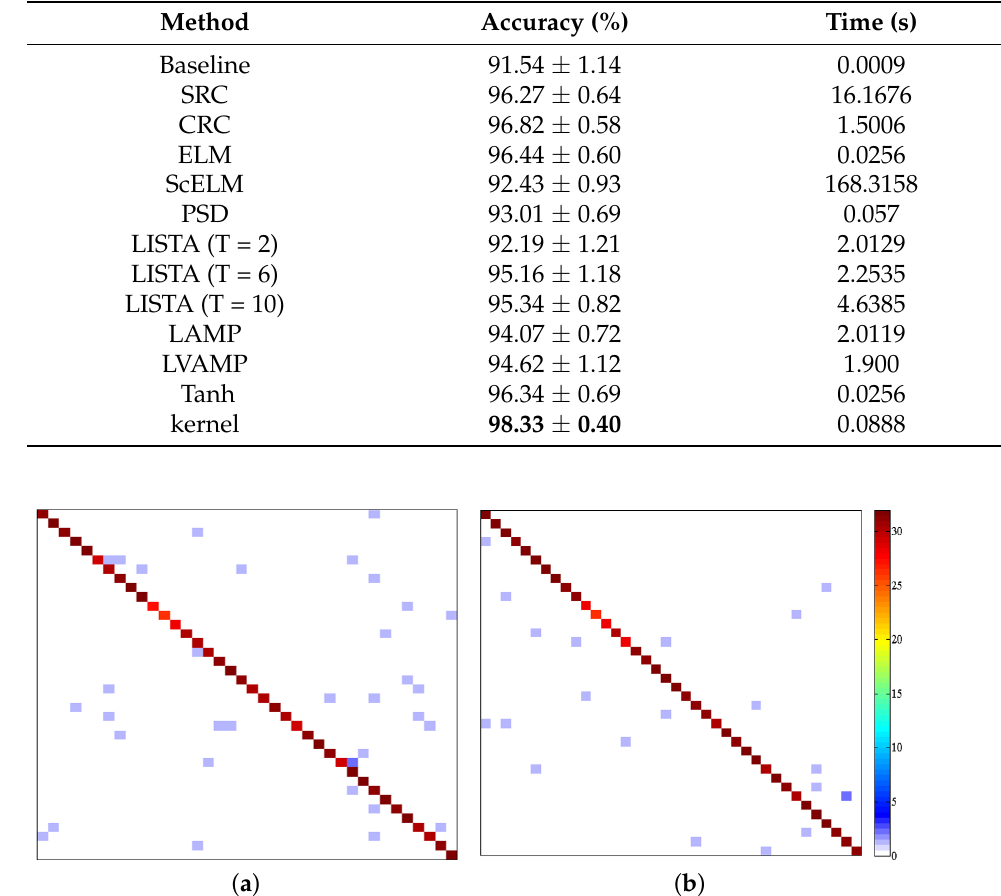
Table 8. Average Recognition Accuracy with Random-Face Features on the Extended YaleB Database.